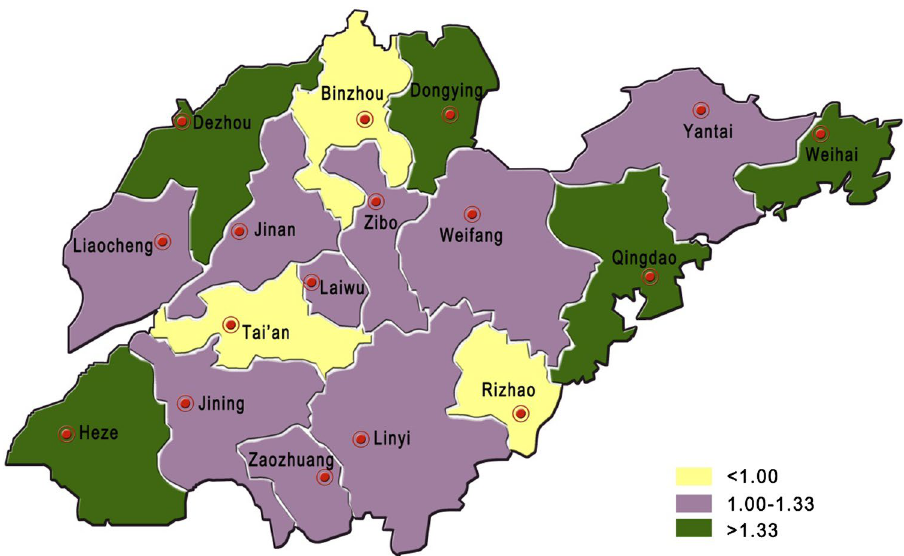
Fig. 1 Spatial distribution